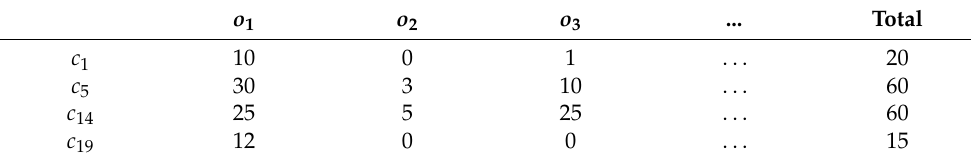
Table 3. Example of calculation of degree of preference and UPS. o 1 o 2 o